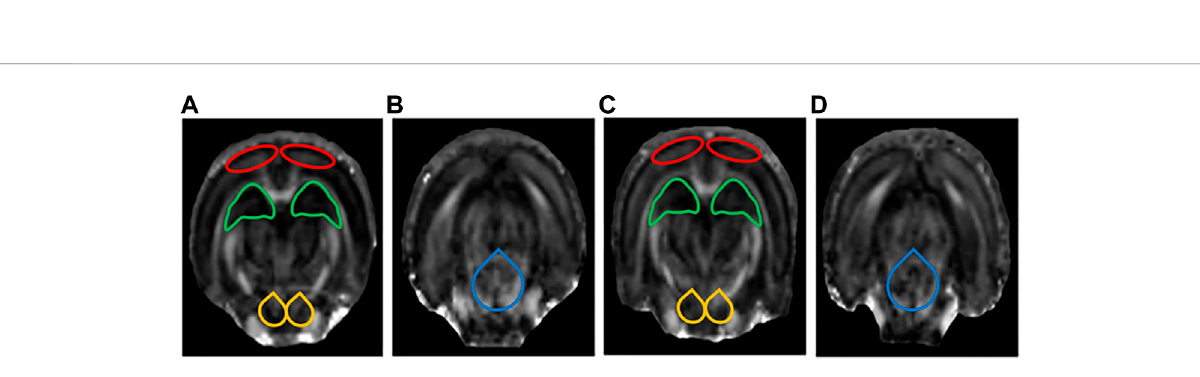
FIGURE 5 Display diagram of FA values ( n = 6). (A) Display diagram of FA values in the prefrontal cortex (PFC), hippocampus (HIP), and ventral tegmental area (VTA) in the control group. (B) Display diagram of FA values in the dorsal raphe nucleus (DRN) in the control group. (C) Display diagram of FA valuesinthePFC,HIP,andVTAintheLPS-4dgroup. (D) DisplaydiagramofFAvaluesintheDRNintheLPS-4dgroup.Theredoutlinesindicatedthe PFC, the green outlines indicated the HIP, the yellow outlines indicated the VTA, and the blue outlines indicated the DRN.